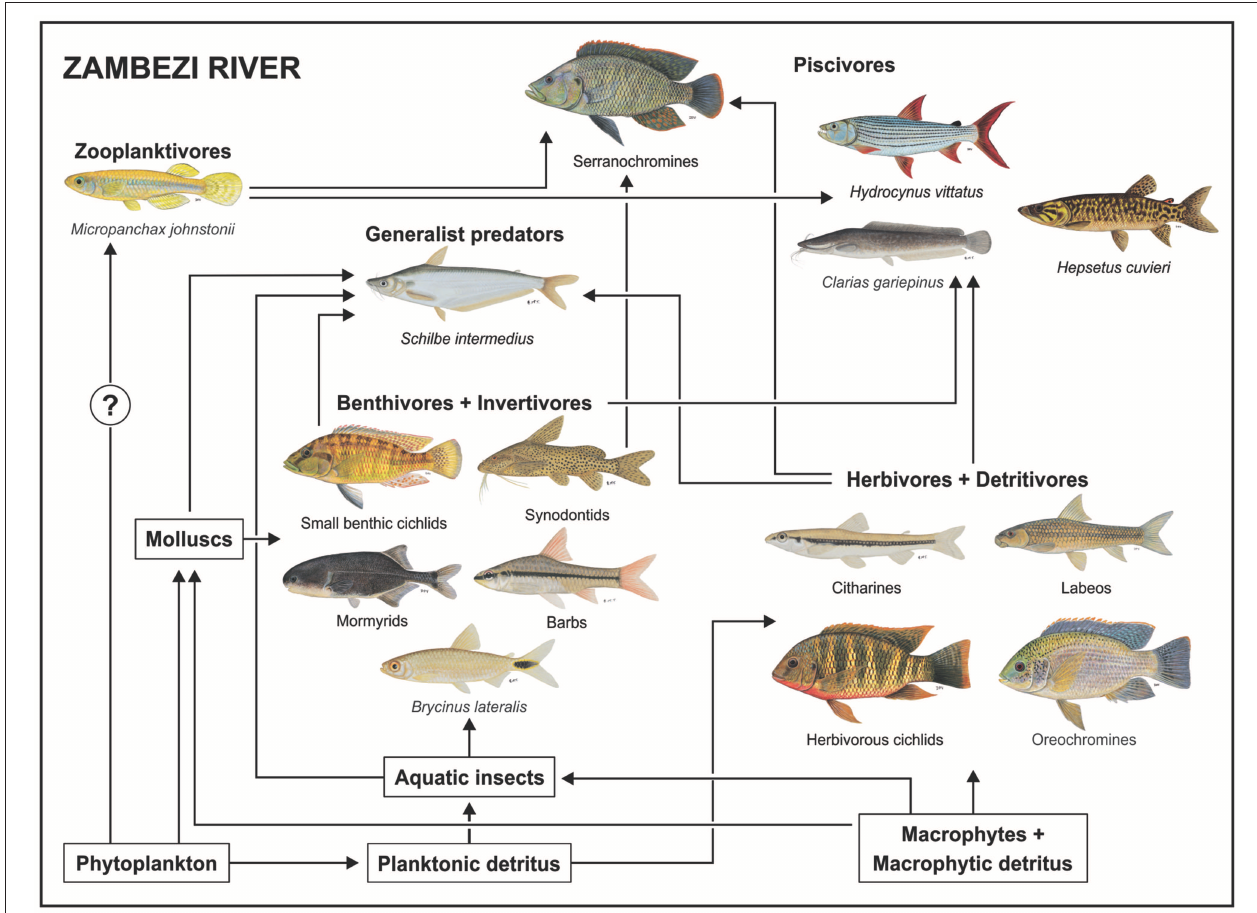
FIGURE 7 | Conceptual diagram of the food web in the Zambezi River as described by Taylor et al. (2017b), illustrating the flow of energy through three major food chains, and their integration by generalist predators and piscivores in the riverine fish community. All fish images are ©